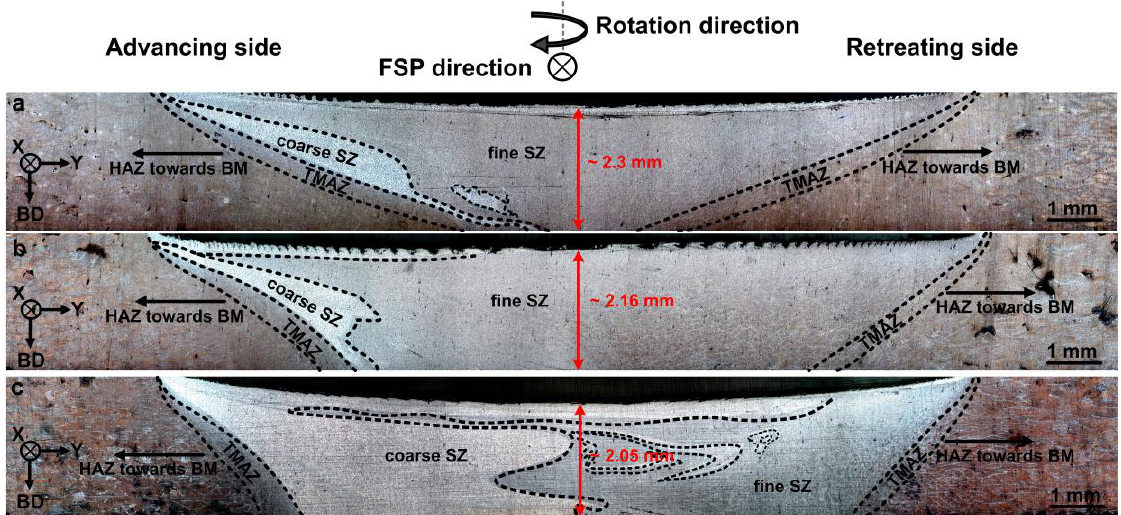
Figure 2. Cross-sectional macrostructure of ( a ) S1, ( b ) S2, and ( c ) S3.